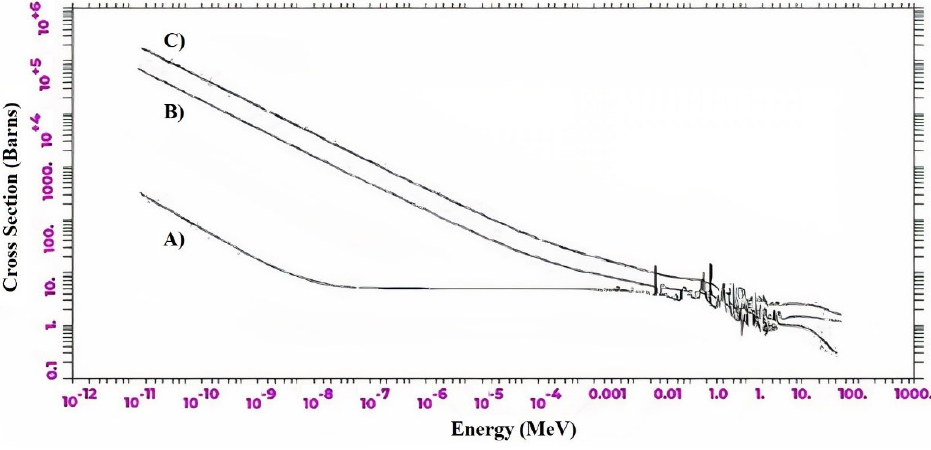
Figure 8. Total neutron cross ‐ section for A) concrete, and metamaterial B) GS2, and C) GS1.